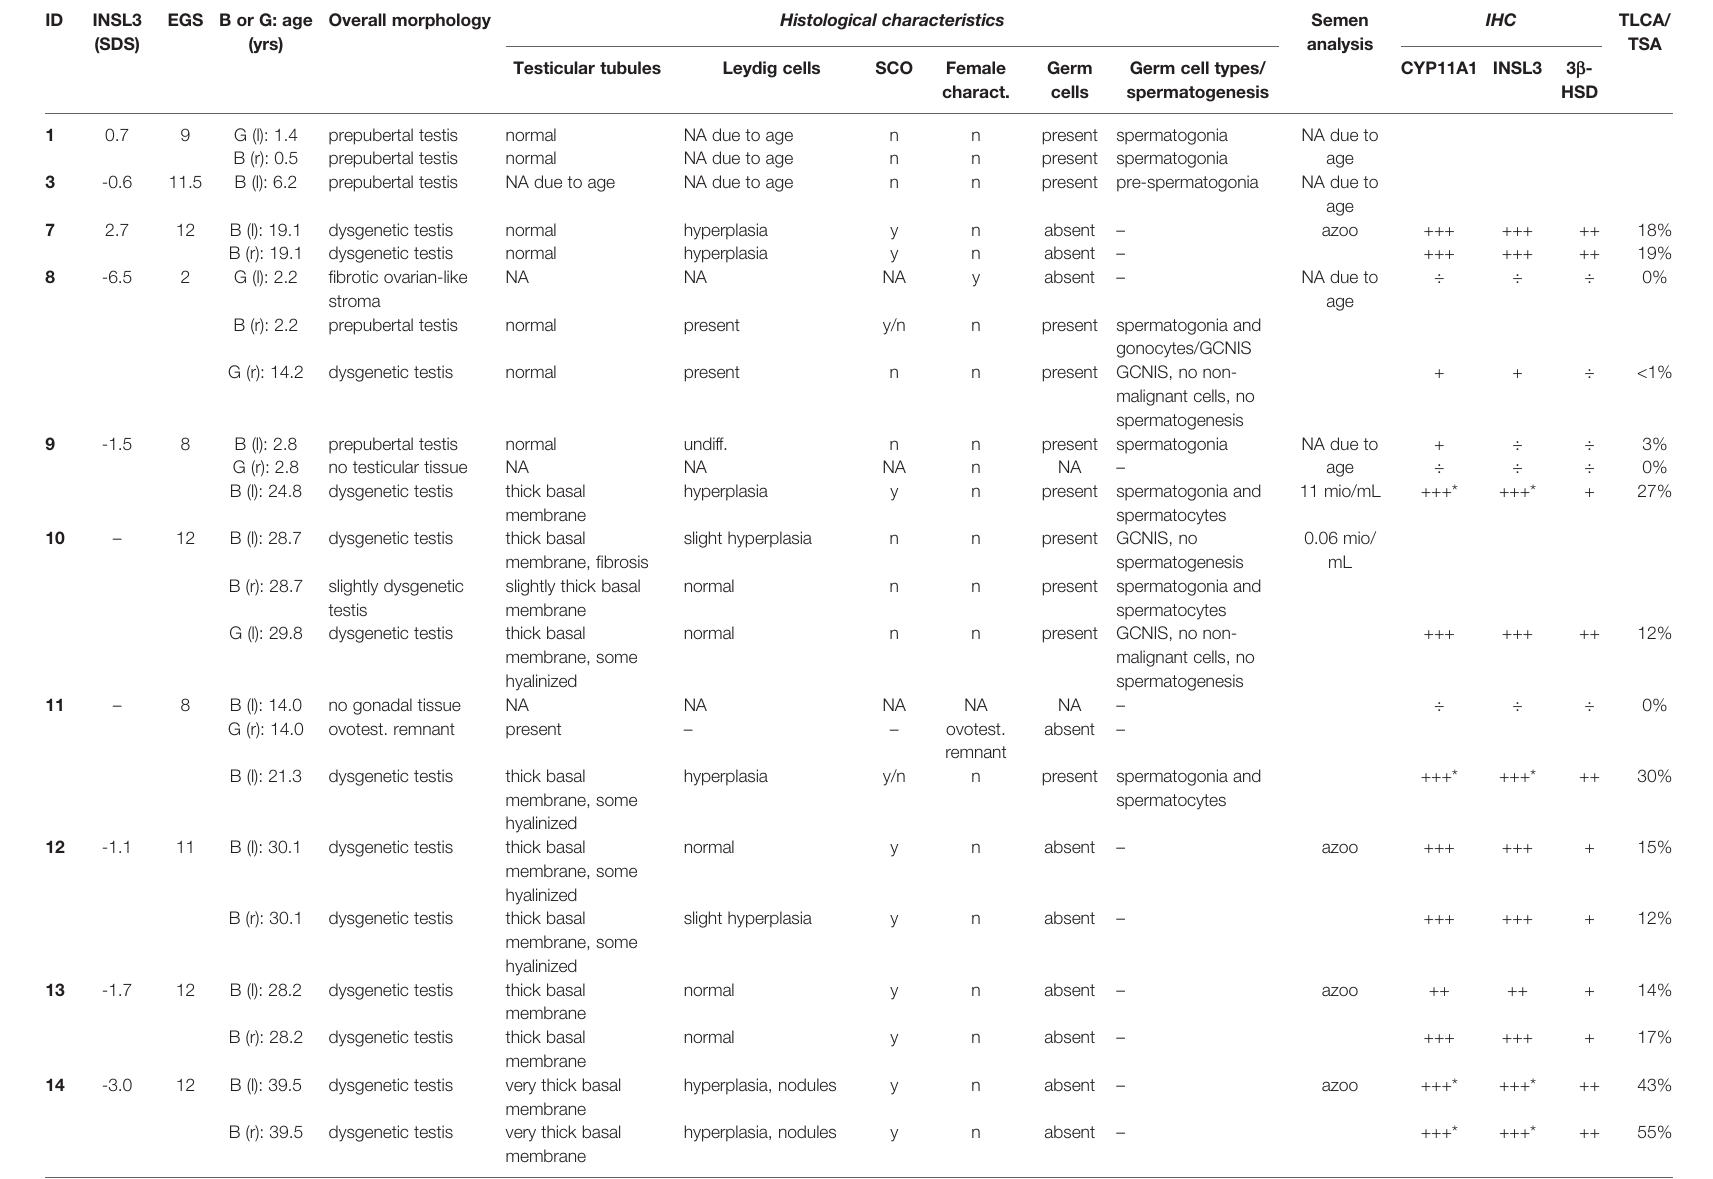
TABLE 2 | Serum insulin-like factor 3 (INSL3) concentrations and histological fi ndings in 13 males with 45,X/46,XY mosaicism. ID INSL3